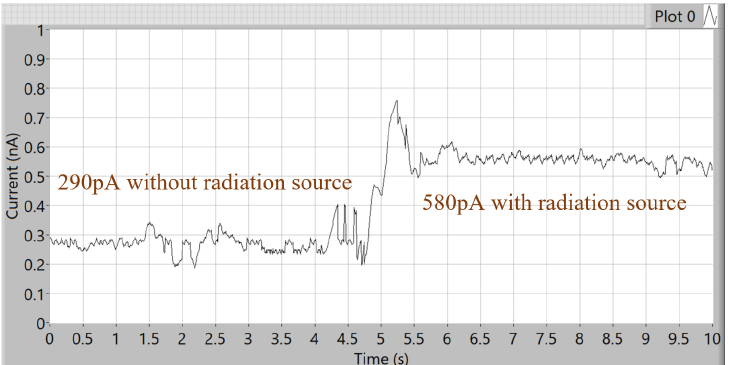
Figure 13. The (Fe-55) source on the GEM.